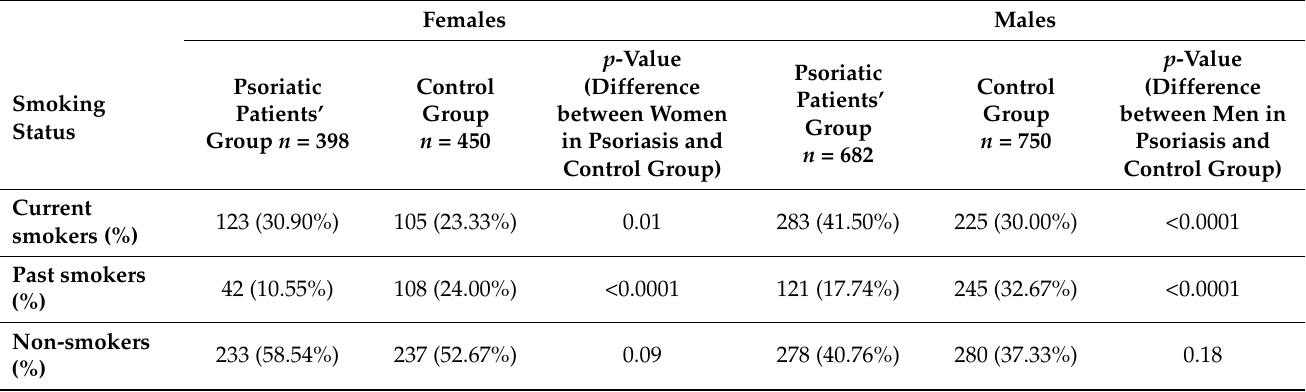
Table 3. Smoking status in females and males in the patients’ and control groups.